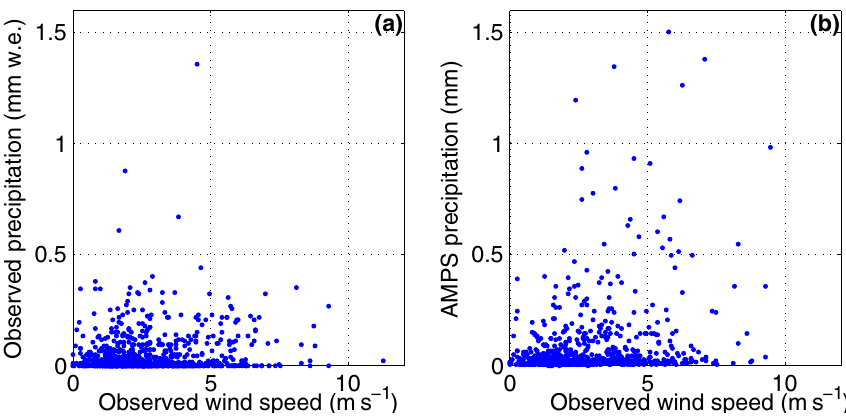
Figure 7. Observed wind speed at AWS vs. observed and modeled 24h precipitation at Dome C.